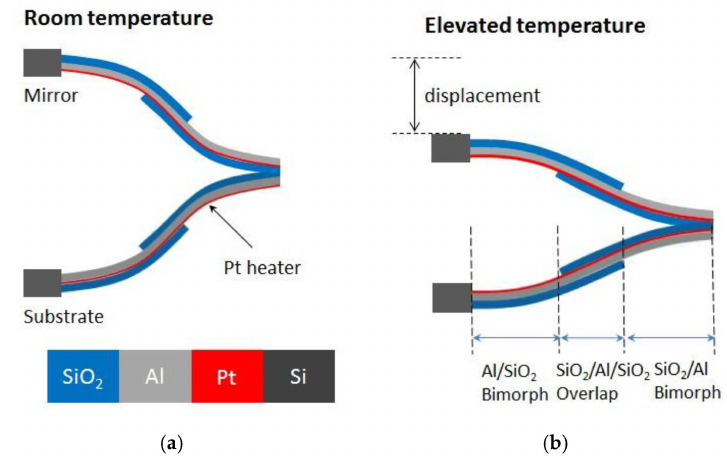
Figure 2. Side view of the ISC S-shaped bimorph actuator. ( a ) No voltage is applied; ( b ) The end of the ISC actuator pulls down the mirror plate when a voltage is